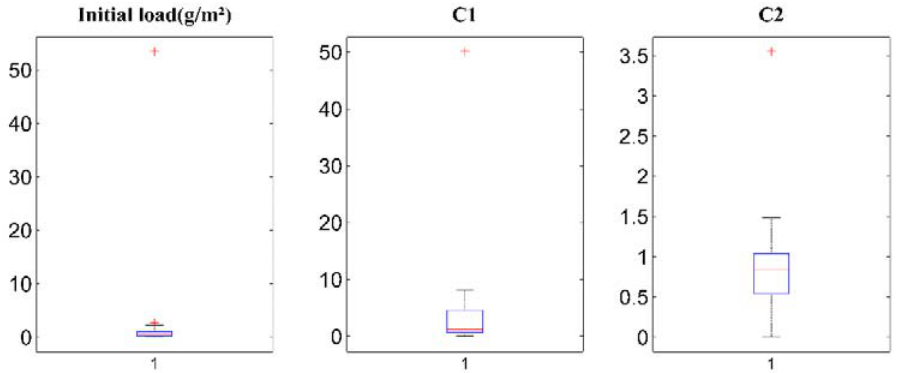
Figure 7. Boxplots of optimal calibrated wash-off parameters. The central mark of each box is the median, the edges represent the 25th and 75th percentiles, and the whiskers extend to the maximum and minimum values that are not considered as outliers.